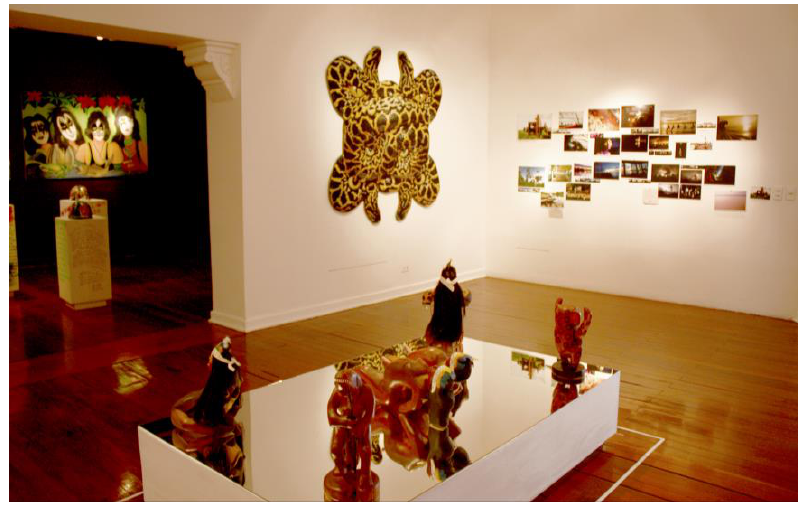
Figure 5. Poder Verde: El desborde amazónico installation view. Photo: Christian Bendayán. Courtesy: Christian Bendayán.